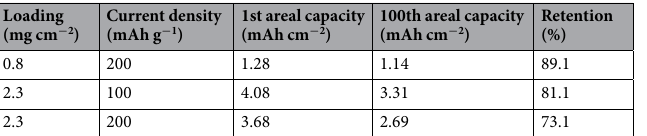
Table 3. Effects of active materials loading and current density on areal capacity (delithiation) performance for C-SCV H + W conducted between 0.002 V to 1.5